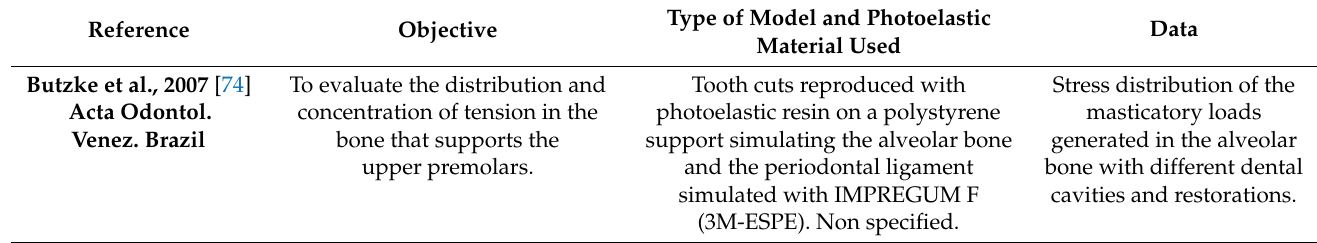
Table 5. Characteristics and findings of studies on operative